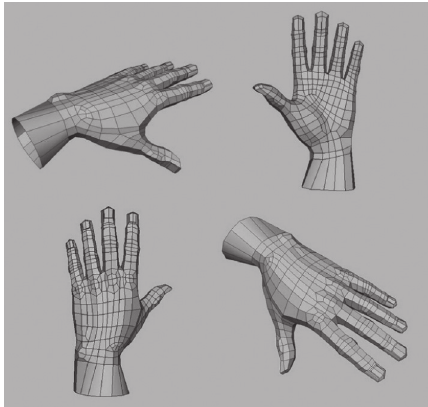
Figure 2: Hand model 3D design.